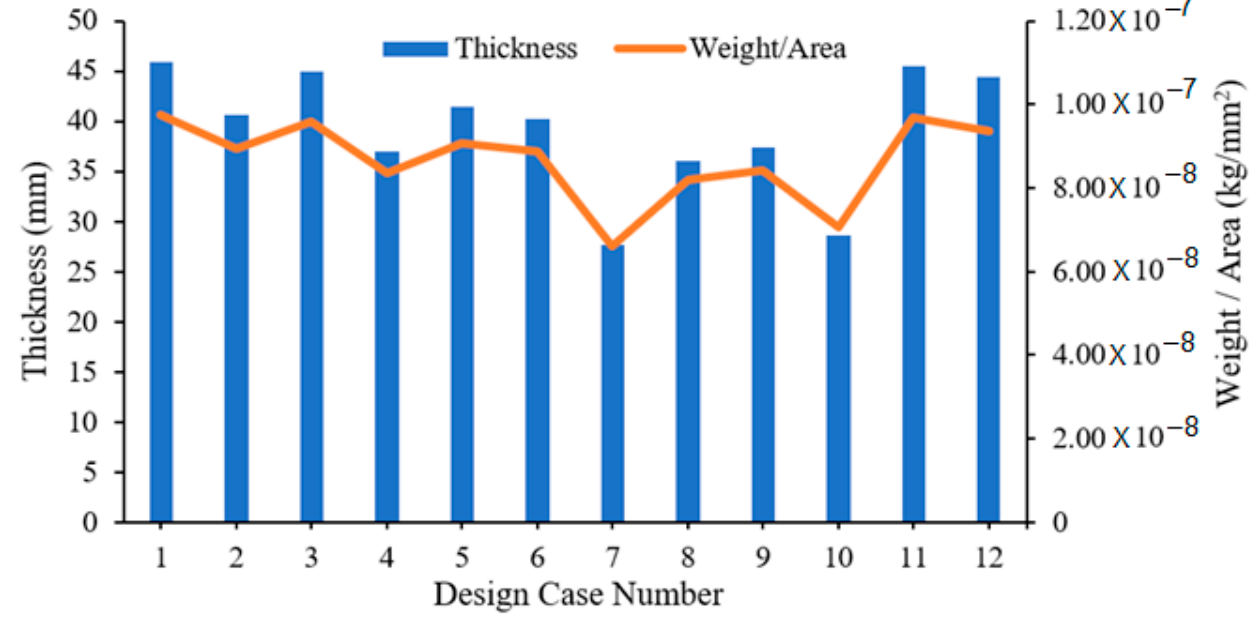
Figure 17. Effect of weight per unit area for 12 different composite riser configurations. Table 12. Considerations for effect of weight per unit area for 12 design